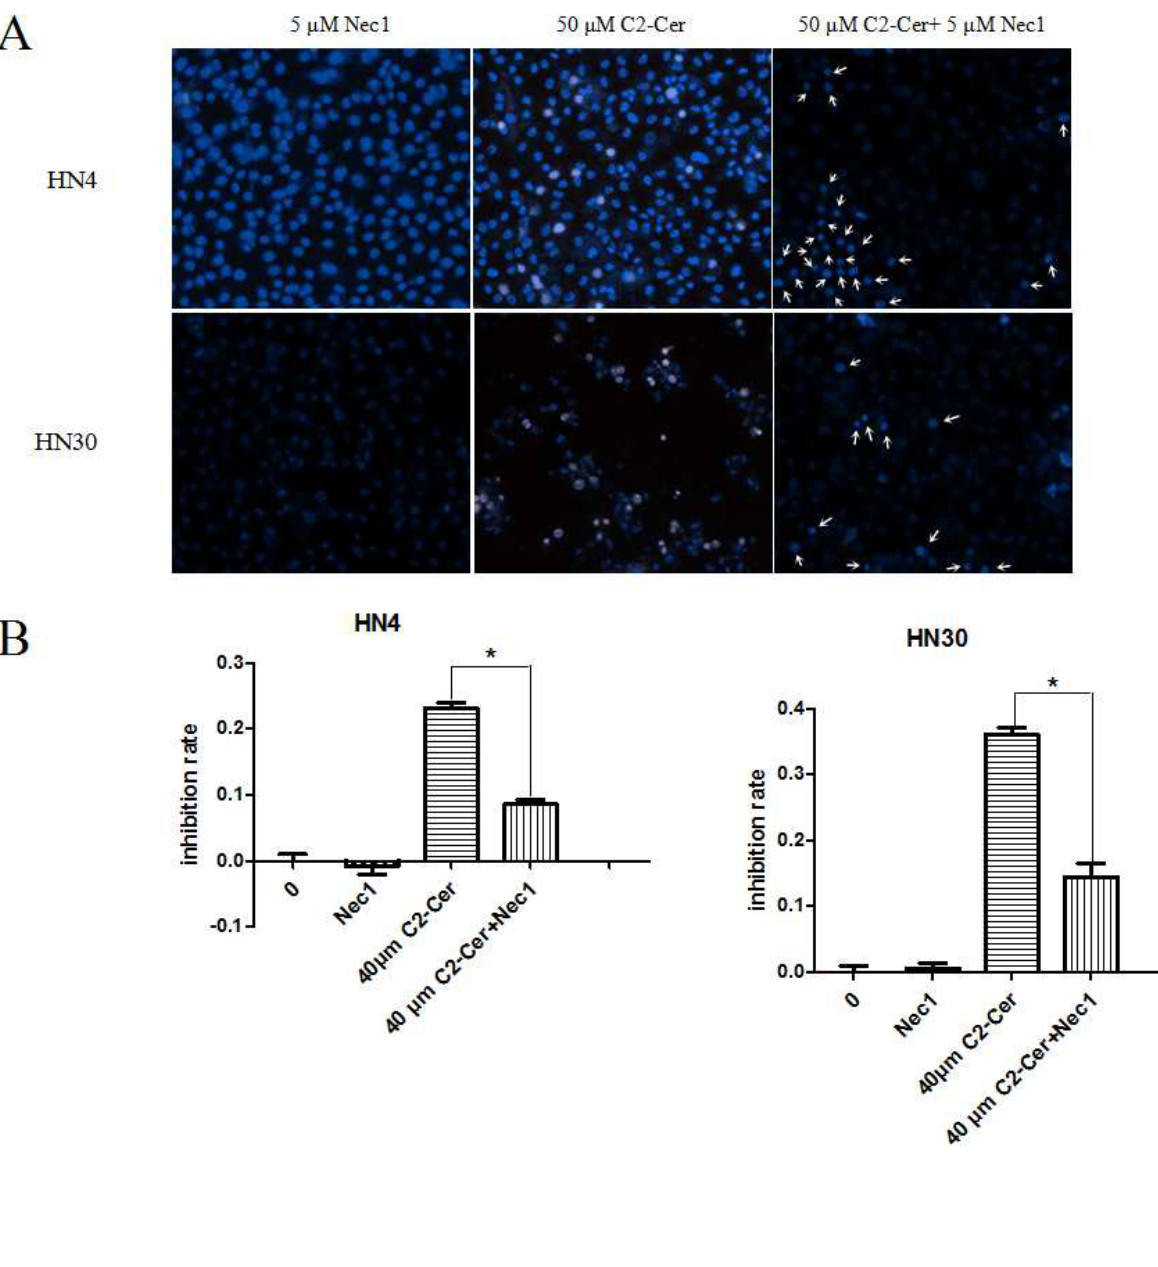
Figure 4. ( A ) Cells were treated with 5 μ M necrostatin-1 (Nec-1), 50 μ M C2-Cer, or 40 μ M C2-Cer plus 5 μ M Nec-1 for 24 h, stained with Hoechst 33342 and PI. No necrotic cells were observed after treatment with Nec-1 except apoptotic cells (apoptotic cells, Hoechst 33342 − /PI++, arrow). The inhibition rate of cell proliferation declined after Nec-1 treatment ( p < 0.05); ( B ) Cells were treated with 5 μ M Nec-1, 40 μ M C2-Cer, or 40 μ M C2-Cer plus 5 μ M Nec-1 for 24 h. The viability of the co-treated cells was higher than that of the C2-Cer treated cells as assessed via the CCK8 assay. ( * : p <